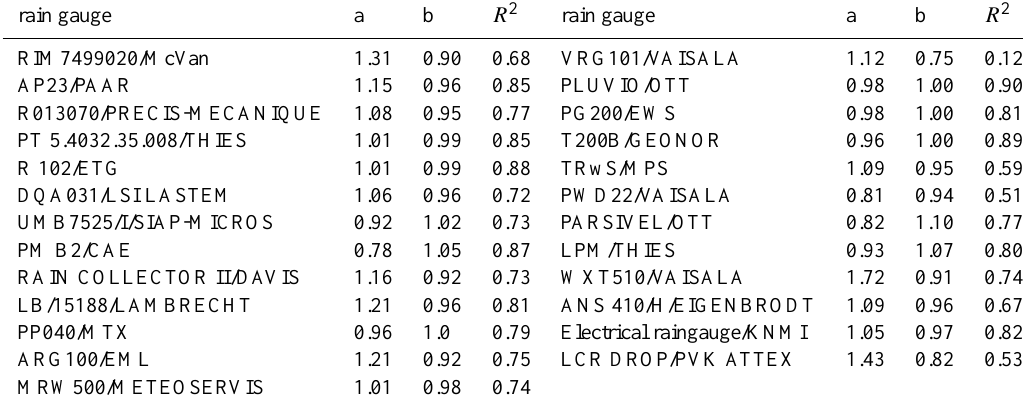
Table 2. Parameters of the regression curves RI = a × (RI ref ) b reported in Fig. 4 (from a to f) for the instruments involved in the intercompar-